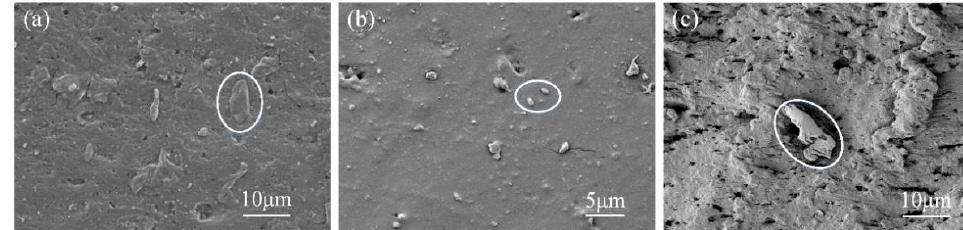
Figure 11. SEM images of wear debris of EPDM material : ( a ) morphology of wear debris of untextured samples; ( b ) wear debris topography with optimal coupling texture parameters; ( c ) wear debris topography with worst coupling texture parameters.